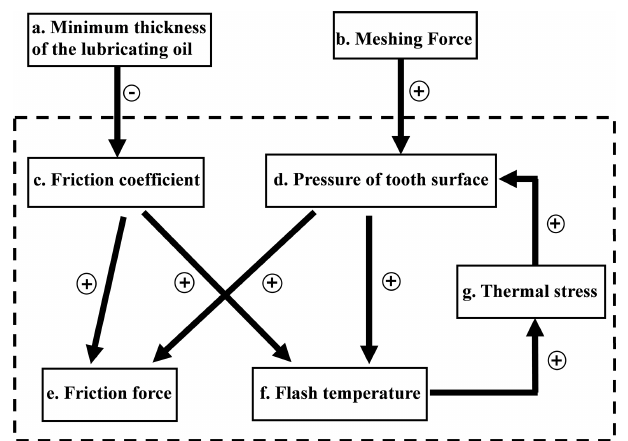
Figure 5. Relationship between the influencing factors of the gear- rotor system.